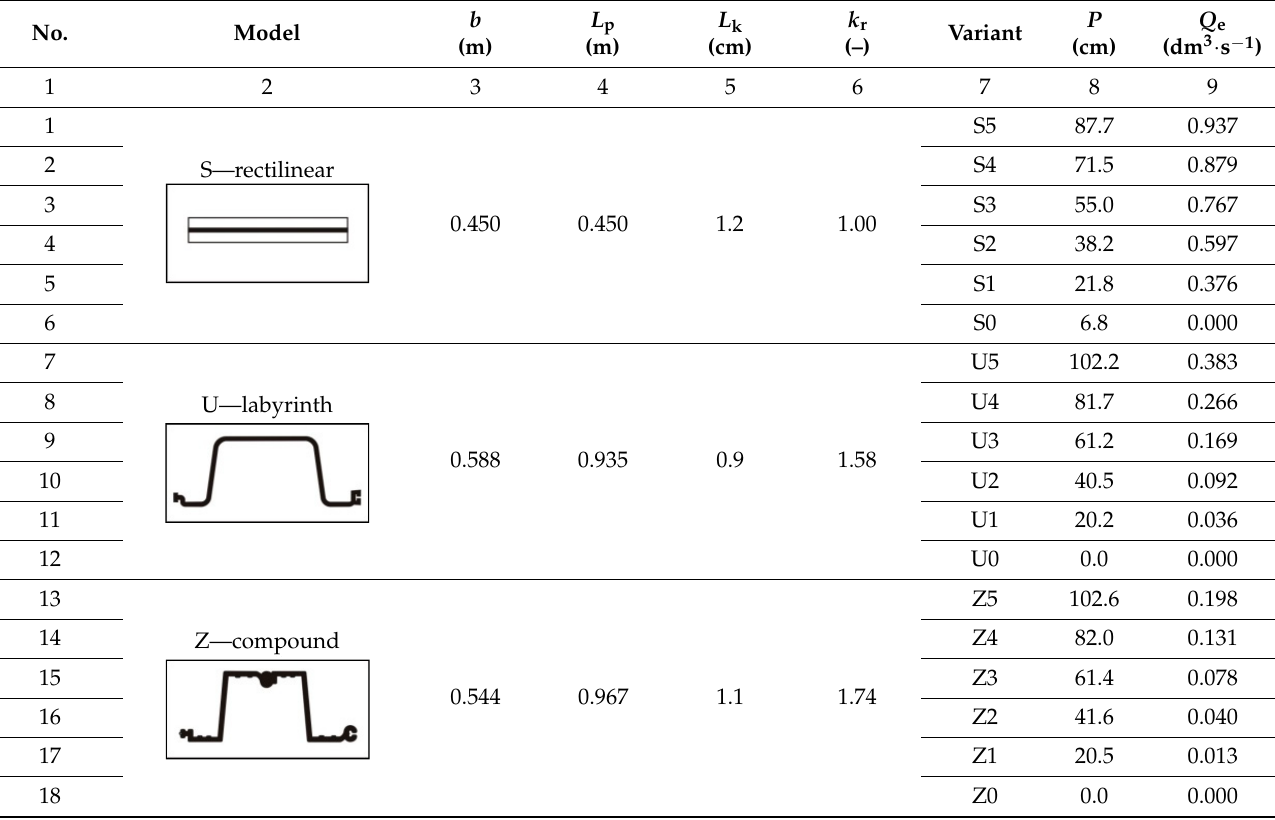
Table 1. Parameters of the tested beam regulators.